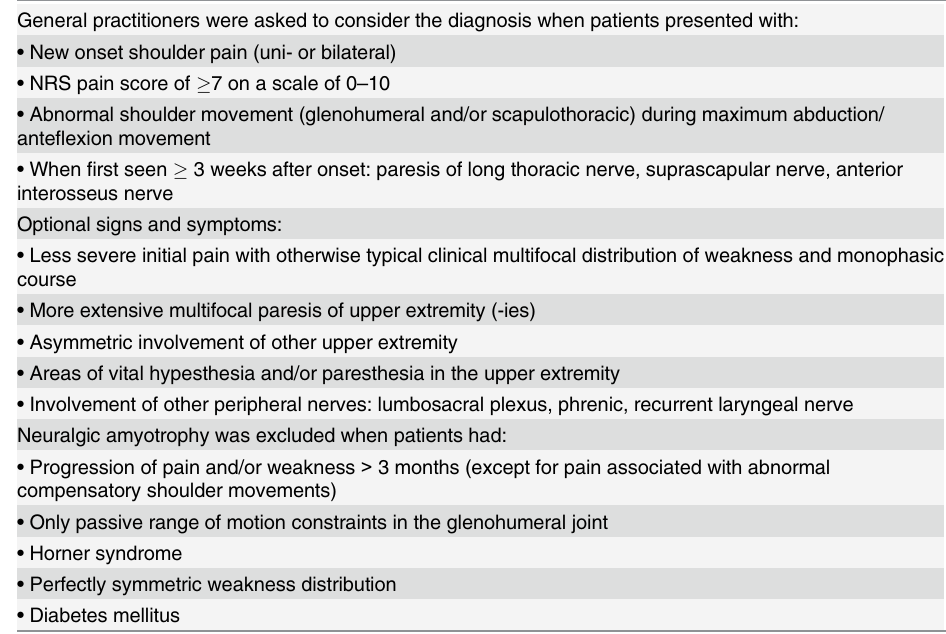
Table 2. Presenting symptoms and exclusion criteria for considering neuralgic amyotrophy as a diagnosis. General practitioners were asked to consider the diagnosis when patients presented